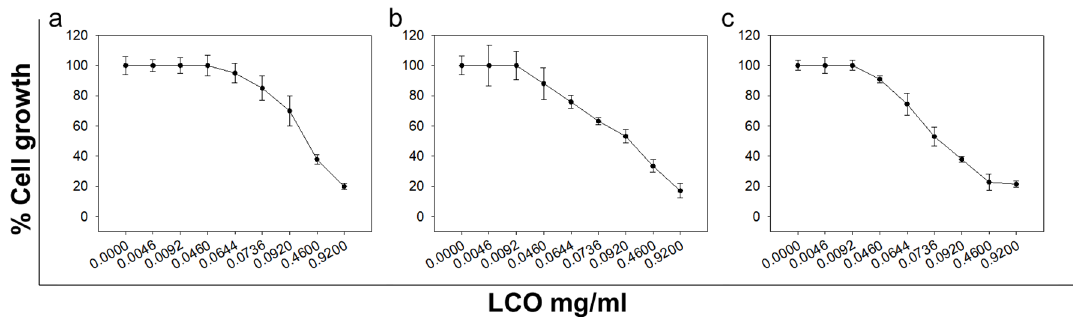
Figure 1. In vitro anticancer activity of LCO. Antiproliferative effect of increasing doses of LCO at ( a ) 24 h, ( b ) 48 h, or ( c ) 72 h on DA3 murine breast cancer cells. Percentage (%) of cell growth was analyzed by the SRB assay. All data shown are representative of at least three independent experiments. Values represent mean ± SD.